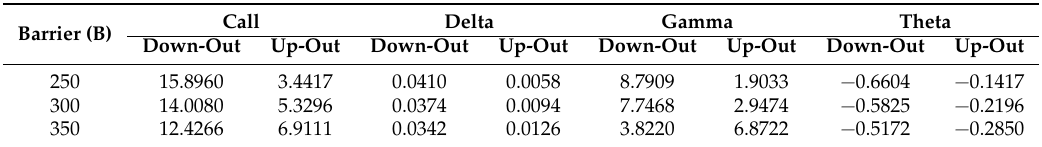
Table 3. Call Price & Sensitivities change with Barrier.